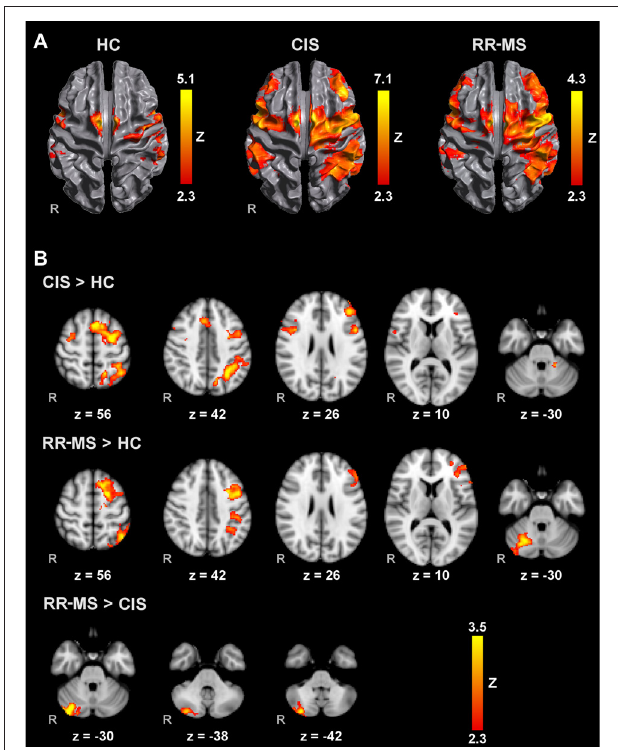
FIGURE 1 | Brain activation during mental squeezing ball movement (MM) with the right hand (A) in healthy controls (HC), clinically isolated syndrome (CIS) and relapsing-remitting multiple sclerosis (RRMS) groups and (B) comparisons between groups. Results are cluster corrected for multiple comparisons ( Z > 2.3; P < 0.05) and are shown overlaid on the MNI template.